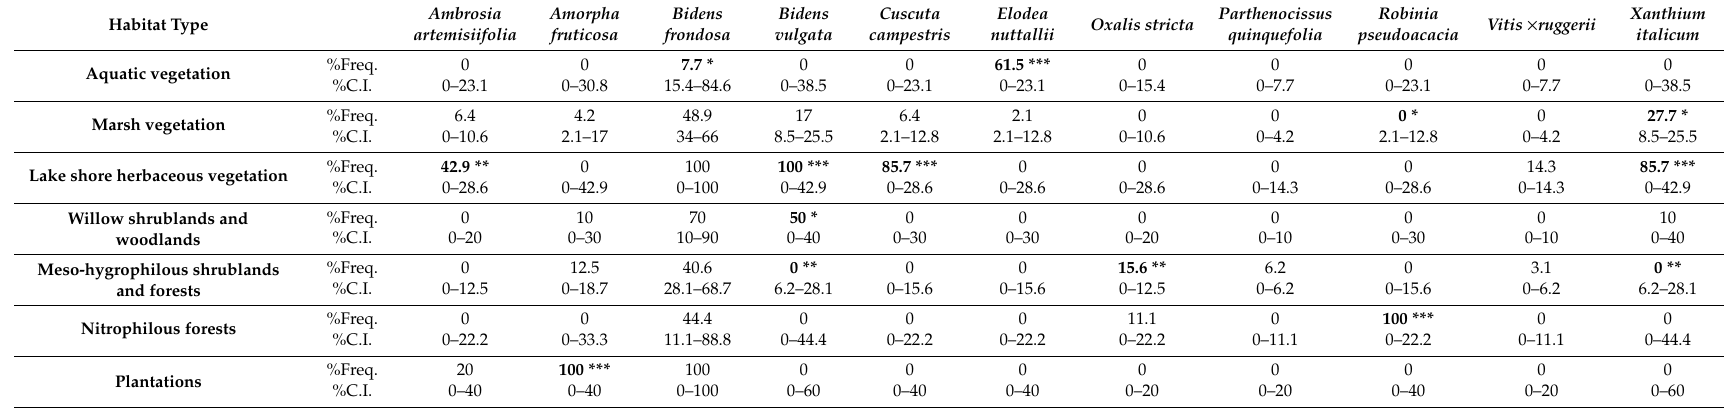
Table 2. For each habitat type, the observed frequencies (expressed as %) of the Invasive Alien Species (IAS) are shown with the 95% confidence intervals (C.I.) obtained from 9999 Monte Carlo simulations. In bold and with asterisks, the observed IAS frequencies are significantly di ff erent than expected (*** p < 0.001; ** p < 0.01; * p < 0.05).